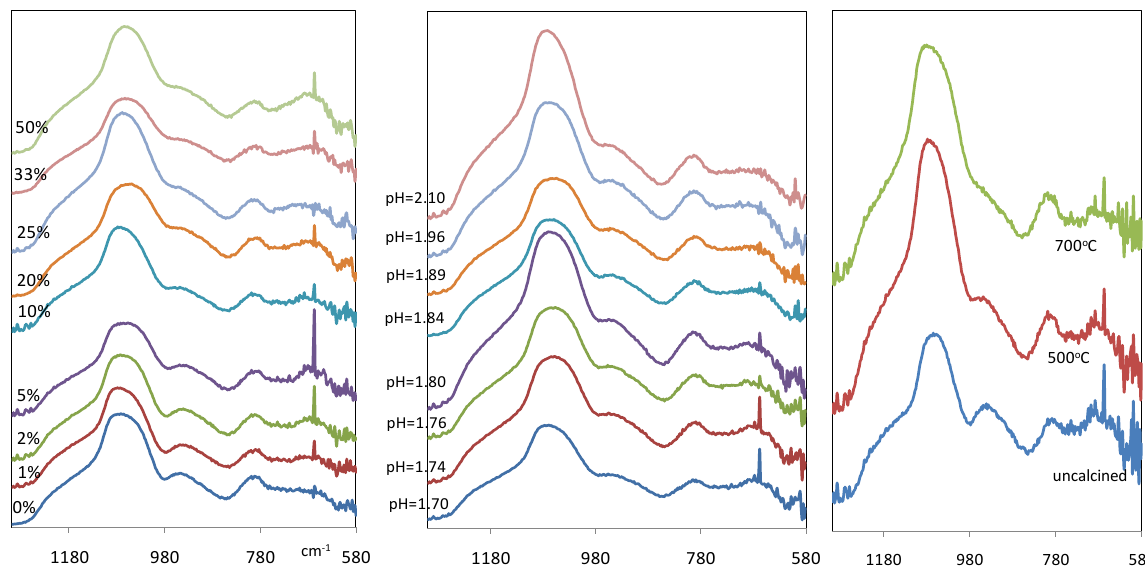
Figure 3. IR spectra of iron oxide silica xerogel samples as a function of ( a-left ) Fe/Si molar ratio; ( b-middle ) pH for 10% Fe/Si molar ratio sample; and ( c-right ) calcinations temperature for 10% Fe/Si molar ratio